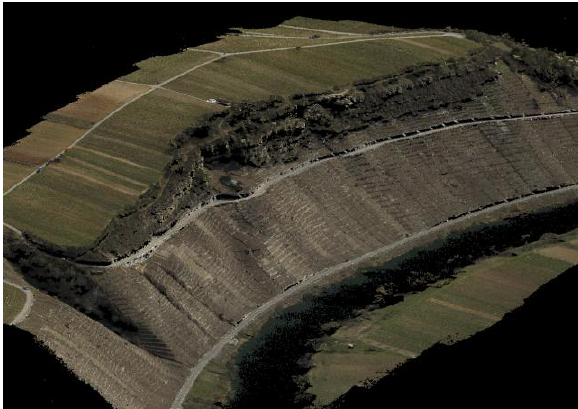
Figure 10: Point cloud for complete test